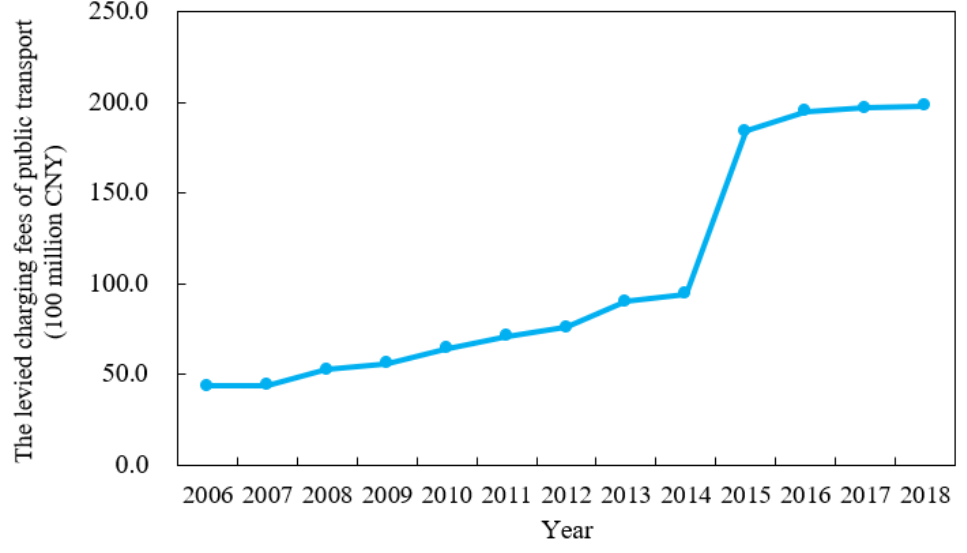
Figure 4. The fees levied for public transport from 2006 to 2018.